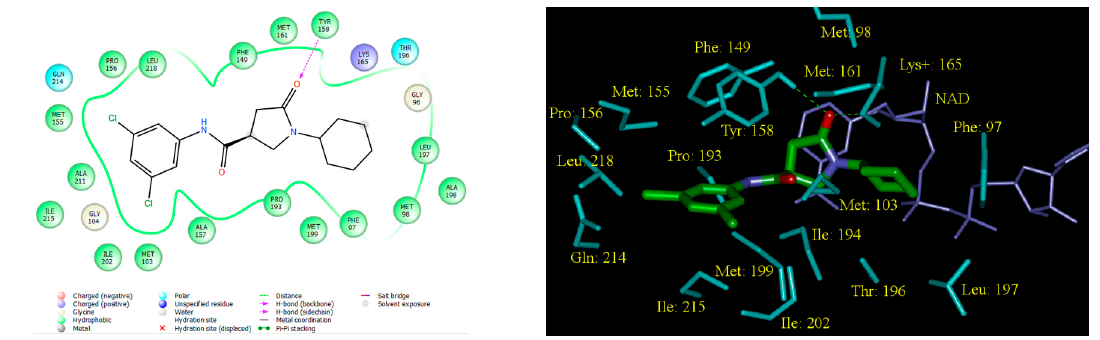
Figure 5. ( Left ) 2D schematic interaction diagram of the most potent inhibitor PCAM9 (Table 1) [12] at the active-site of InhA of MTb ; ( Right ) 3D structure of the active-site with bound inhibitor PCAM9.